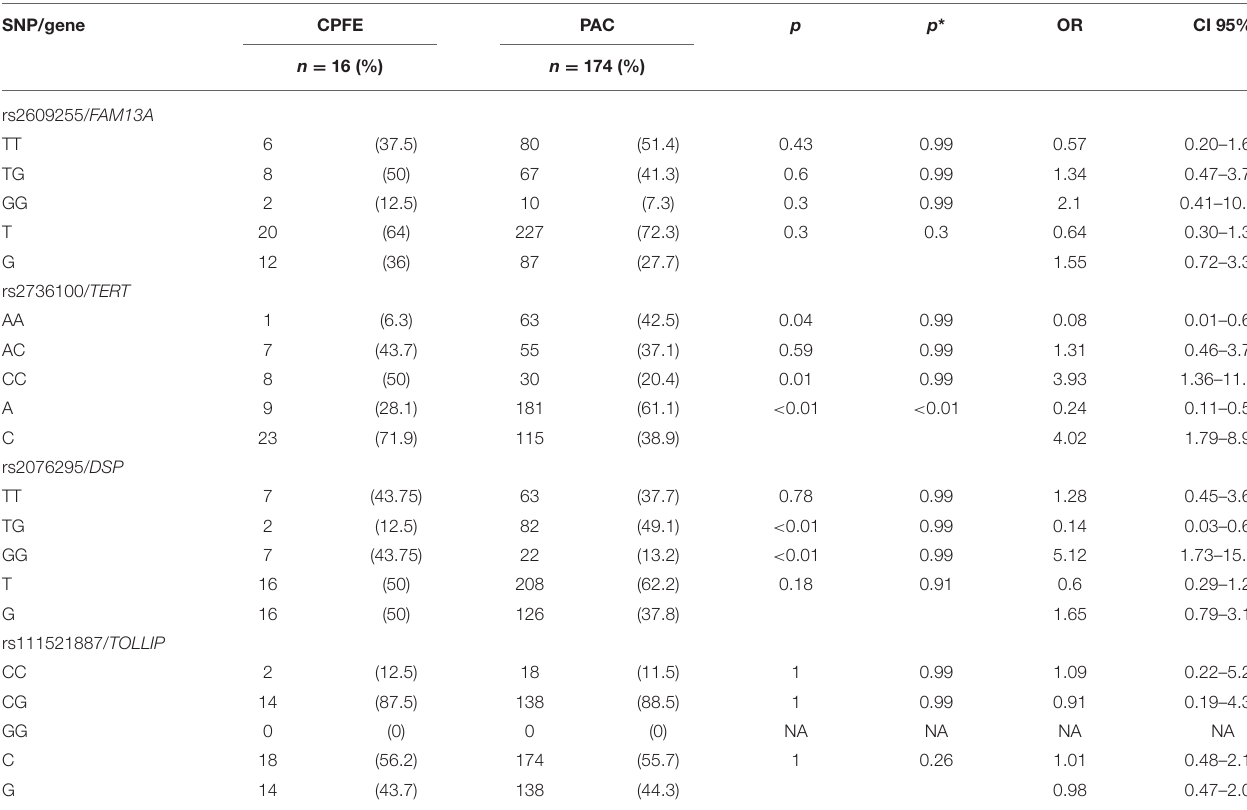
TABLE 4 | Allele and genotype frequencies of CPFE vs. PAC comparison. SNP/gene